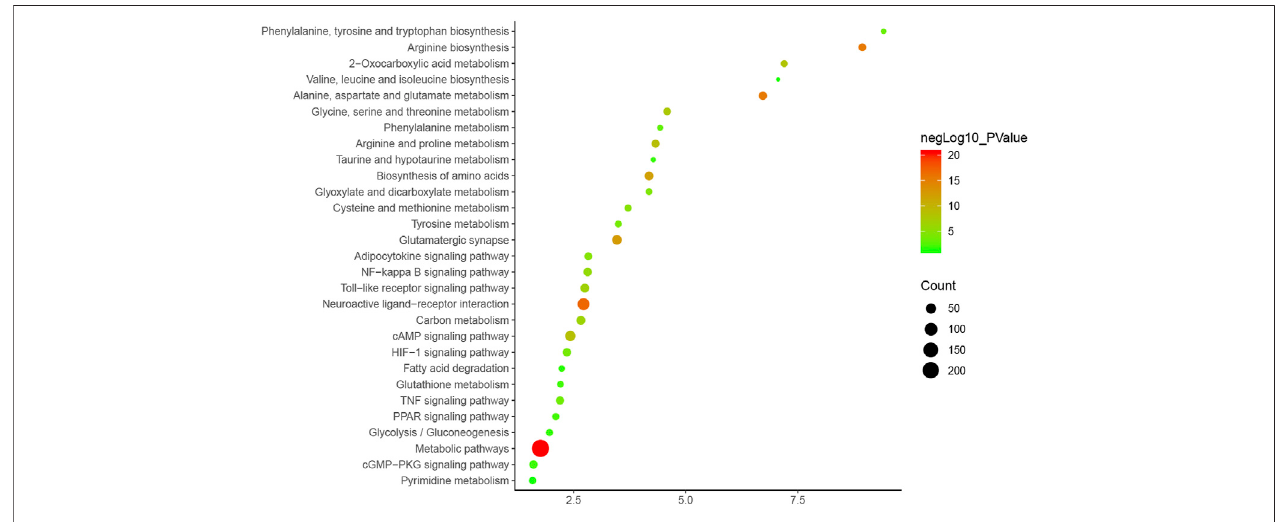
FIGURE 8 | Bubble chart of signaling pathway (X-axis stand for fold enrichment).